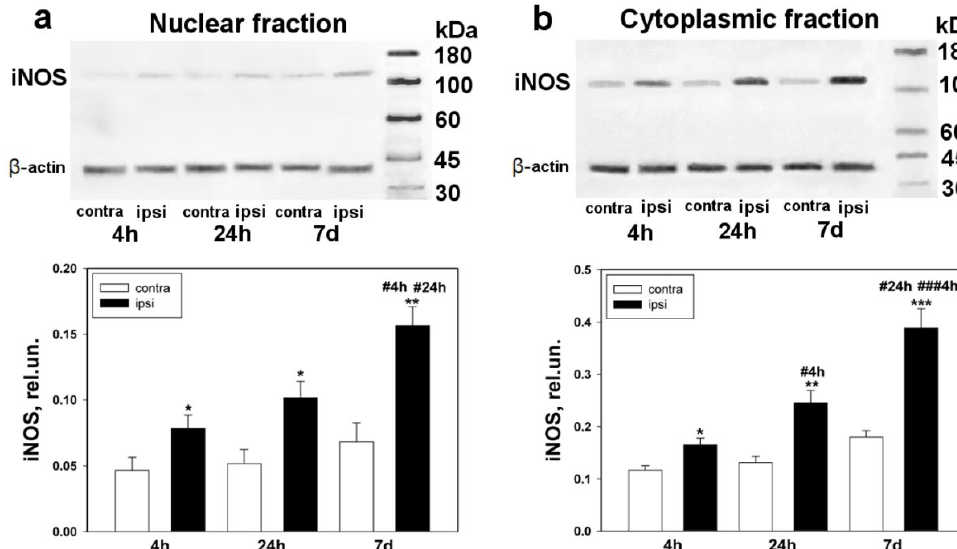
Figure 4. Western blot analysis. The expression of iNOS in the ipsilateral and contralateral DRGs 4 h, 24 h, and 7 days after sciatic-nerve transection. ( a ) Nuclear fraction; ( b ) cytoplasmic fraction. One-way ANOVA. Мean ± SEM. n = 6. * p < 0.05, ** p < 0.01, *** p < 0.001—ipsilateral DRG with respect to the contralateral DRG of the same animal; # p < 0.05, ### р < 0.001—ipsilateral DRG with respect to the ipsilateral DRG, at different time intervals (with respect to 4 h and 24 h).